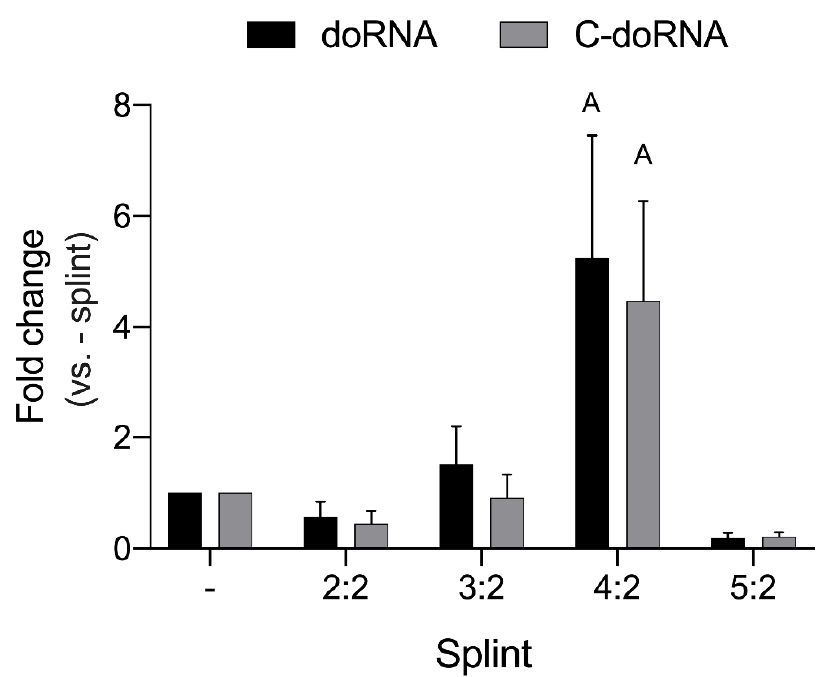
Figure 2. Optimization of the DNA splints. Splints of various length were assessed for their ability to optimize 5’ ligation RT-qPCR detection of doRNA and C-doRNA. Cycle quantitation (Cq) data were normalized on U6 RNA, and the fold changes were calculated versus the optimal 4:2 splint condition (mean ± SEM; n = 3 independent experiments). Letters above the bars represent conditions with a normalized fold change significantly different from the control (without splint,-splint): A, p < 0.0097 (two-way ANOVA with Holm–Sidak’s post hoc test).